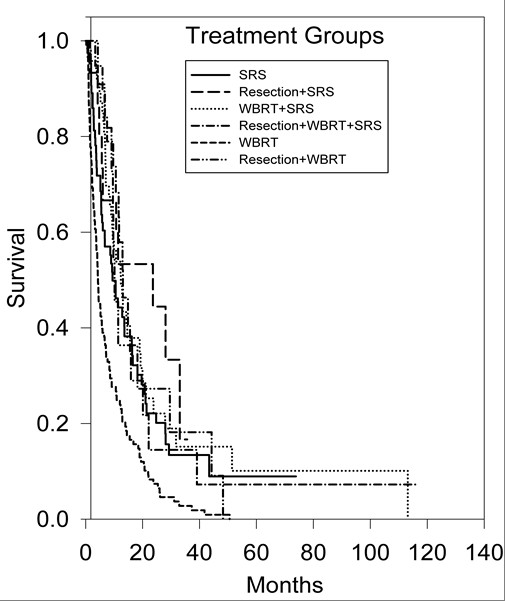
Kaplan-Meier survival curve illustrating overall survival based on treatment modality.